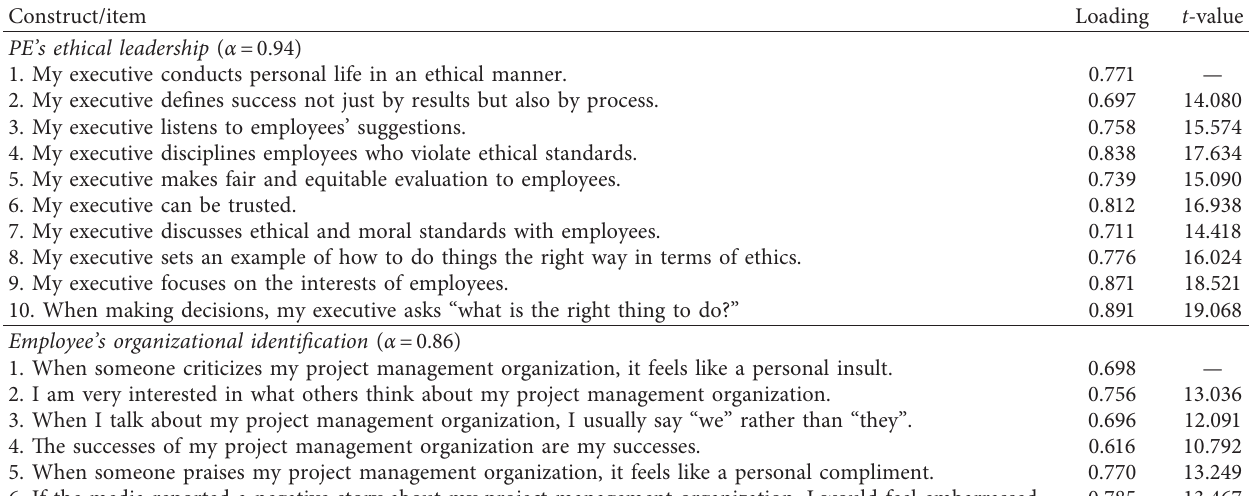
Table 2: Measurement